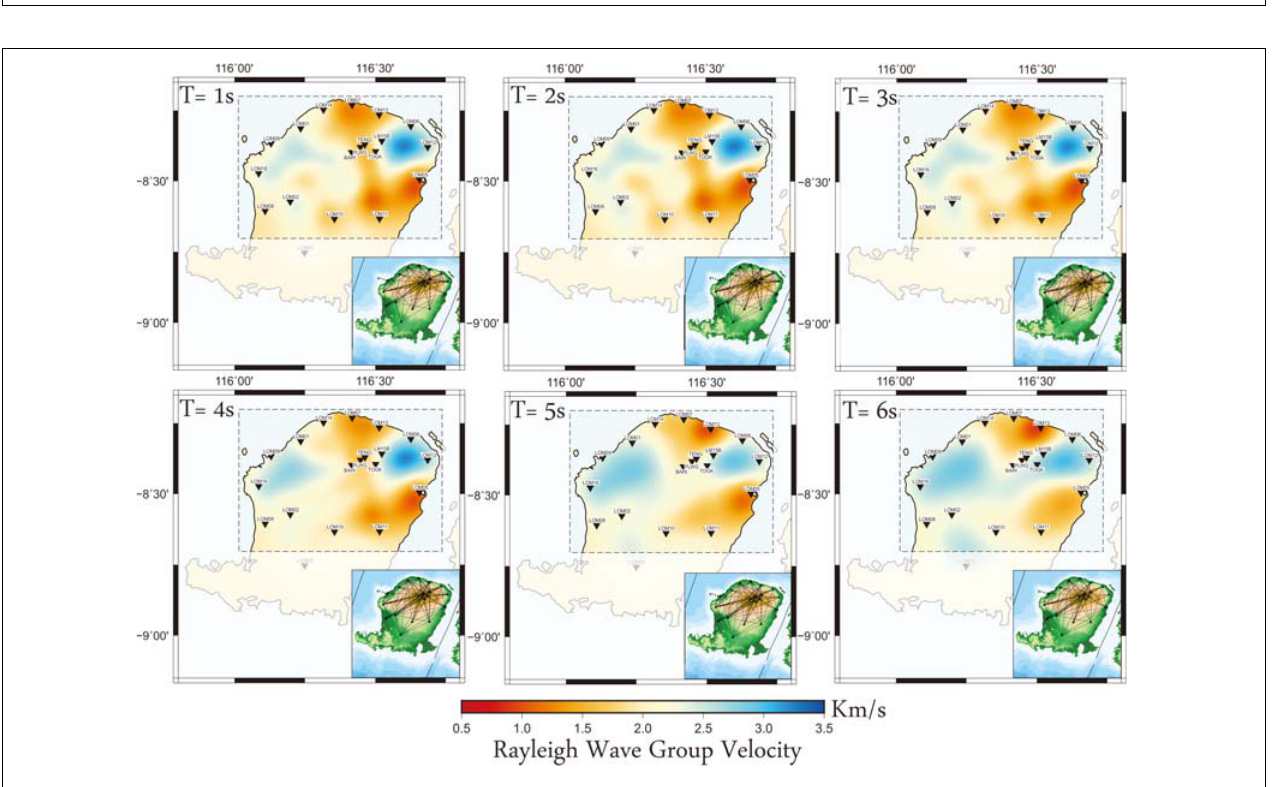
Frontiers in Earth Science |